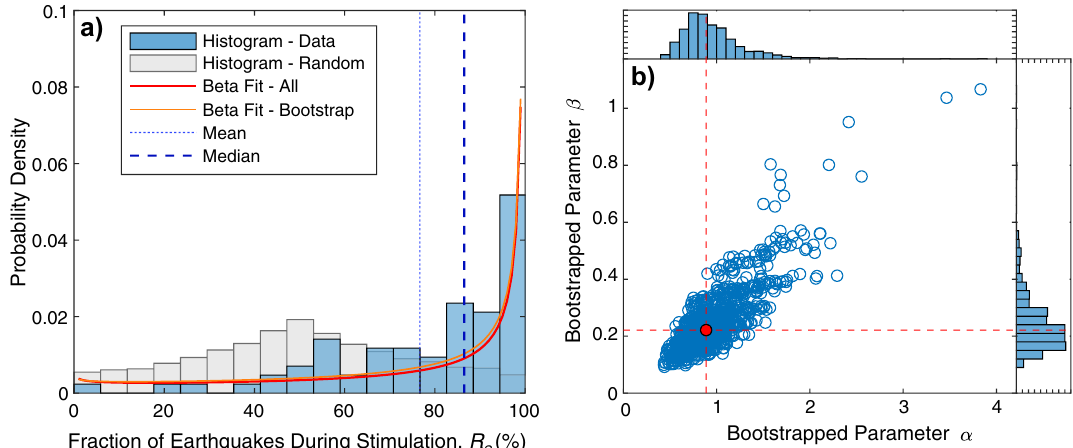
Figure 2. The empirical distribution of R S and bootstrapped beta distribution fit. ( a ) Histogram of R S for all the induced seismicity cases (blue bars) with its median and mean values (vertical lines), best fit to the beta distribution (crimson lines), compared against a random distribution (grey bars). ( b ) Scatterplot of bootstrapped beta distribution parameters (blue circles) with the best fit parameter (red circle). Inset histograms show the univariate distribution of beta